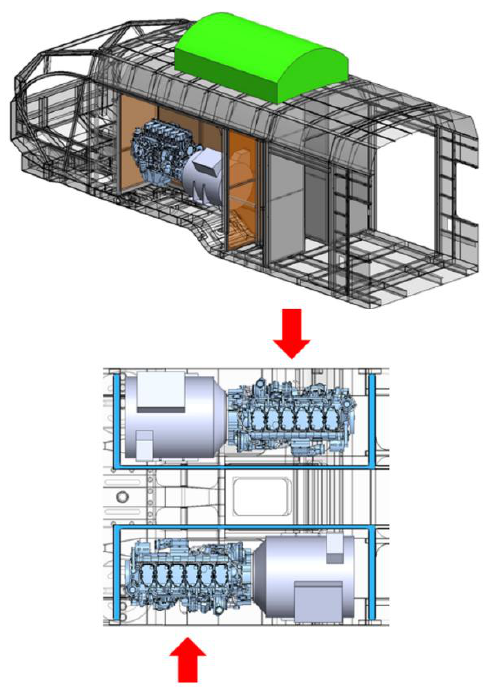
Fig. 14. Location of machine room spaces; red arrows indicate the direc- tion from which it will be possible to access and service the engine and the traction generator (top view)